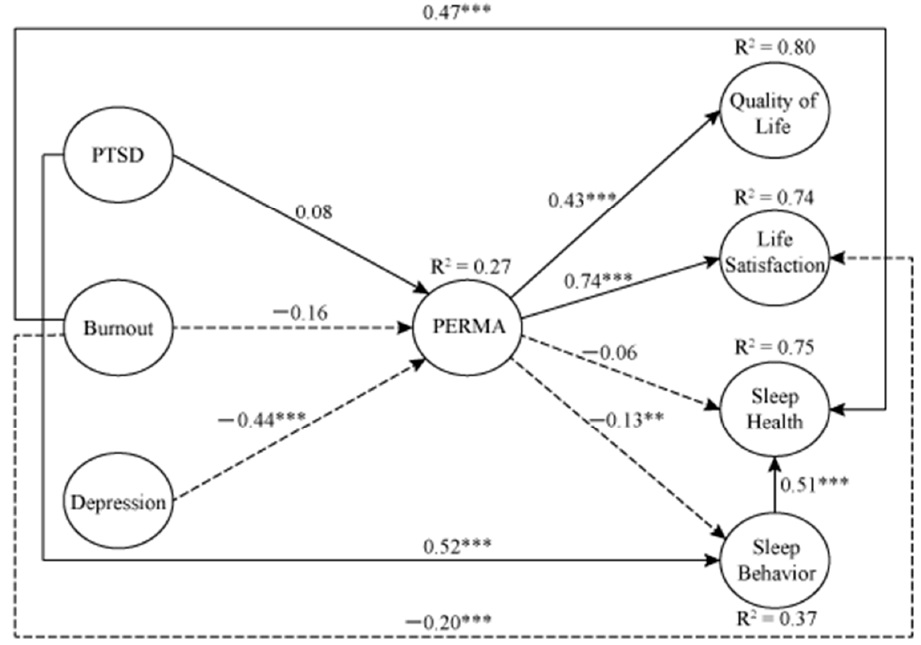
Figure 2. Results of testing variables. Note. PTSD: post-traumatic stress disorder syndrome; PERMA: positive emotion, engagement, relationship, meaning, and achievement. ** p < 0.01. *** p < 0.001.